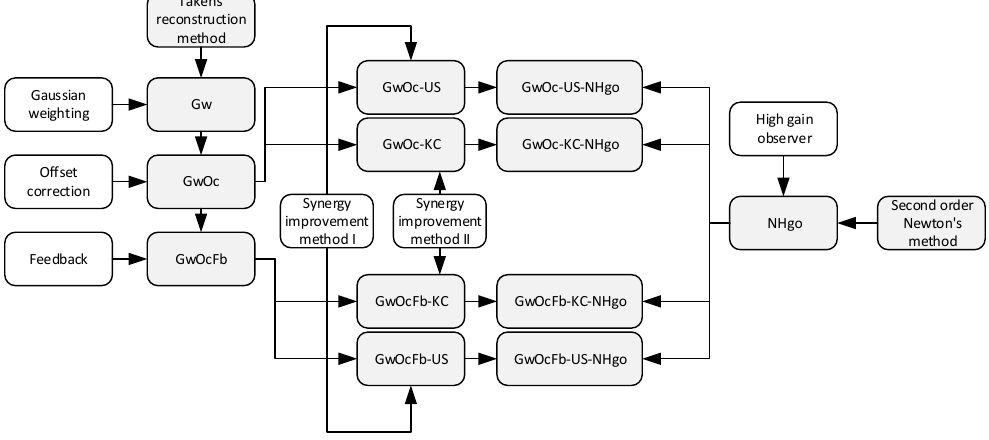
Figure 6. The relationship map of different methods and improving